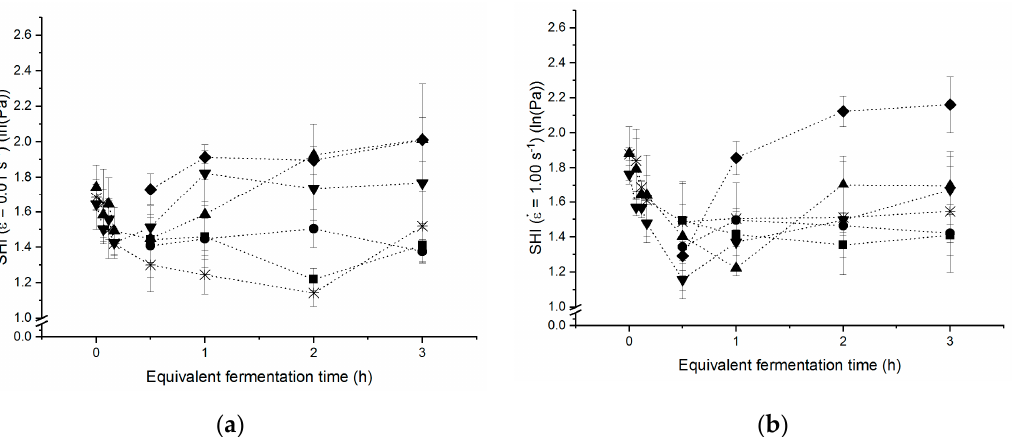
Figure 4. Strain hardening behaviour of yeasted dough with different yeast concentrations and yeast metabolites during 3 h fermentation at 30 °C. ( a ) Strain hardening index for an elongation rate of ε b = 0.01 s − 1 . ( b ) Strain hardening index for an elongation rate of (cid:2239) (cid:2184) (cid:4662) = 1.00 s − 1 . ( ) Reference without additives, ( ▲ ) 1 g yeast/100 g flour , ( ▼ ) 2 g yeast/100 g flour, ( ♦ ) CO 2 , ( ■ ) succinic acid, ( ● ) ethanol. (n = 3, (cid:1850)(cid:3364) ± STD).